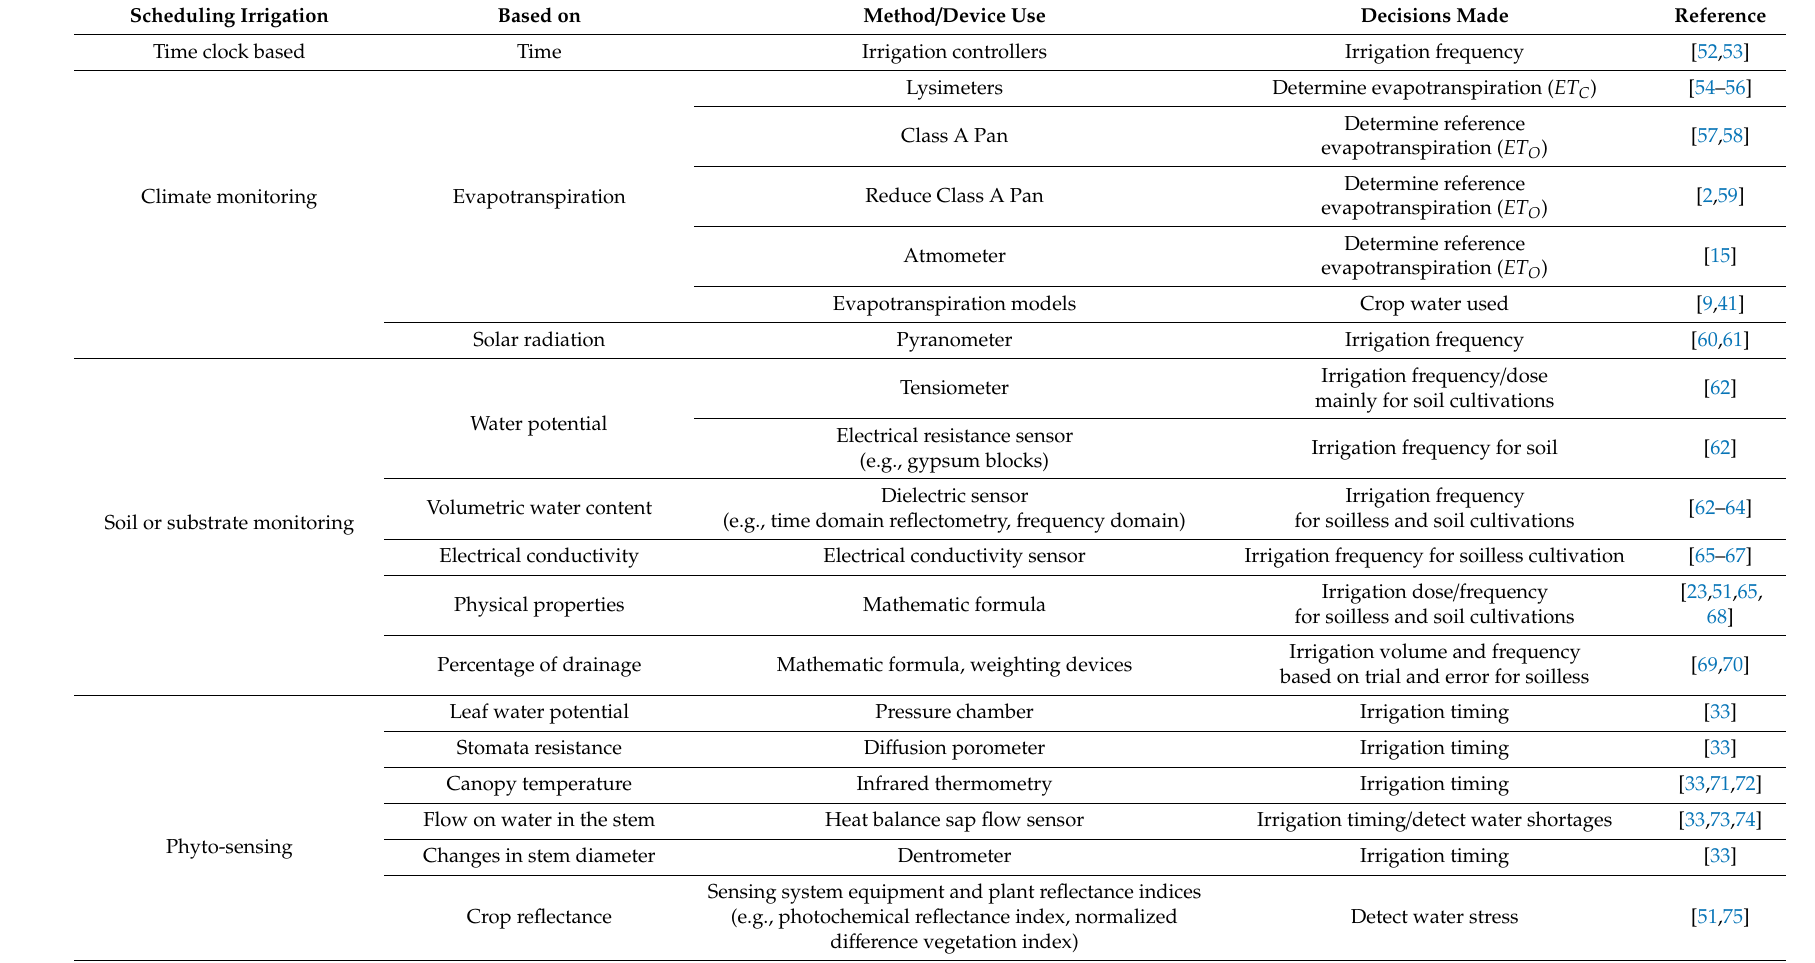
Table 1. Greenhouse irrigation methods for soil and soilless greenhouse cultivation